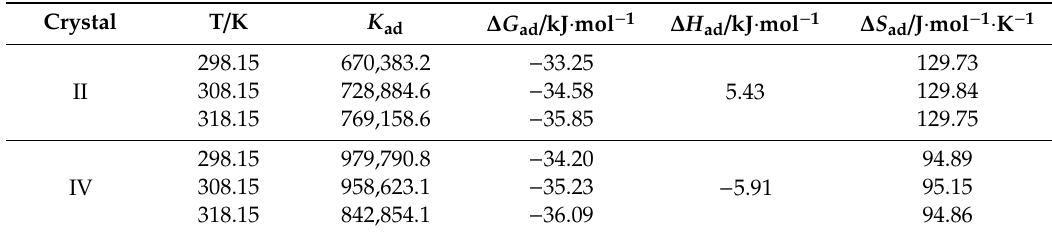
Table 3. Determination results of thermodynamics.